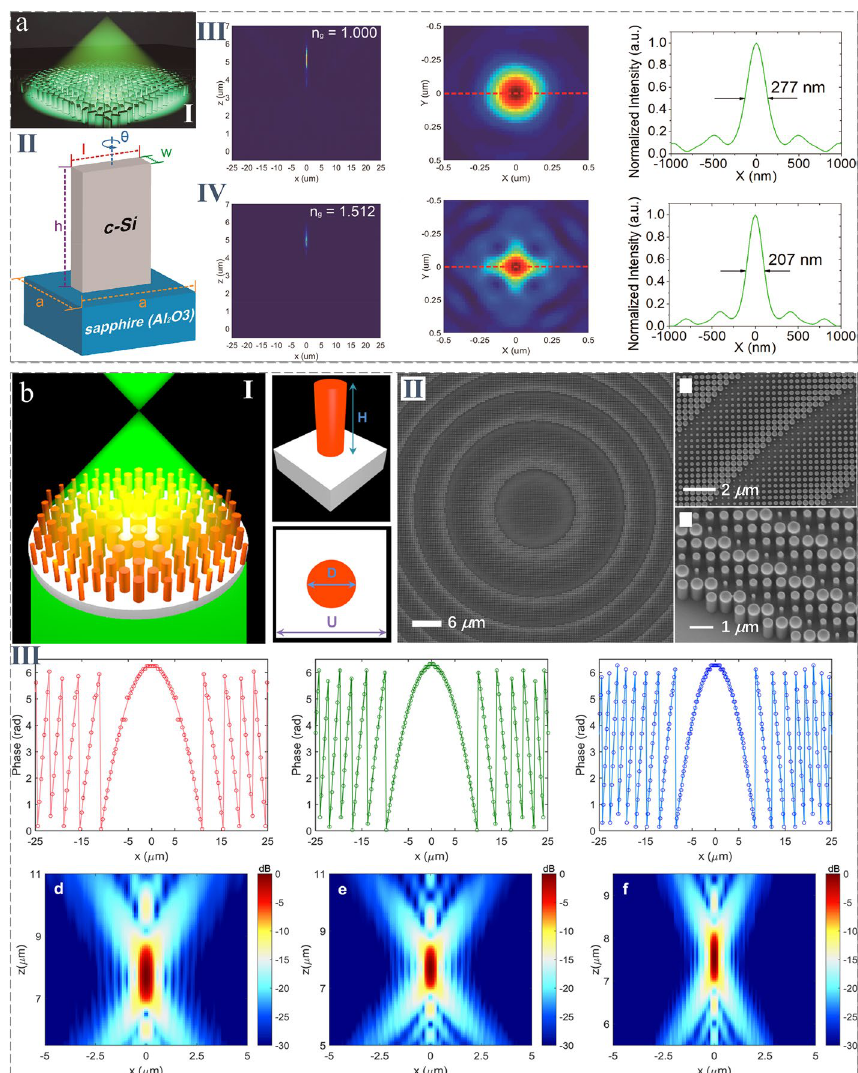
Fig. 6 (a) (I) Schematic of the c -Si meta-lens. (II) Meta-lens consists of c -Si nanobricks on a sapphire substrate. Focusing performance of the meta-lens in air (III) and immersion oil (VI). (b) (I) Schematic of a meta-lens operating in transmission mode (left panel). Right panel: Side view and top view of the meta-lens building block. Top view SEM image of the center portion (left side of (II)) and a portion at higher magnification (right-top of (II)) of the fabricated meta-lens. Side view SEM image of the edge of the meta-lens (right-bottom of (II)). (III) Solid lines: required analog phase. Circles: digitized phase profiles of the meta-lenses designed at wavelengths of 660 nm (left), 532 nm (middle), and 405 nm (right). Corresponding 2D simulated intensity profiles at focal planes. (a) Reproduced with permission [160]. Copyright 2018, American Chemical Society (ACS). (b) Reproduced with permission [119]. Copyright 2016,